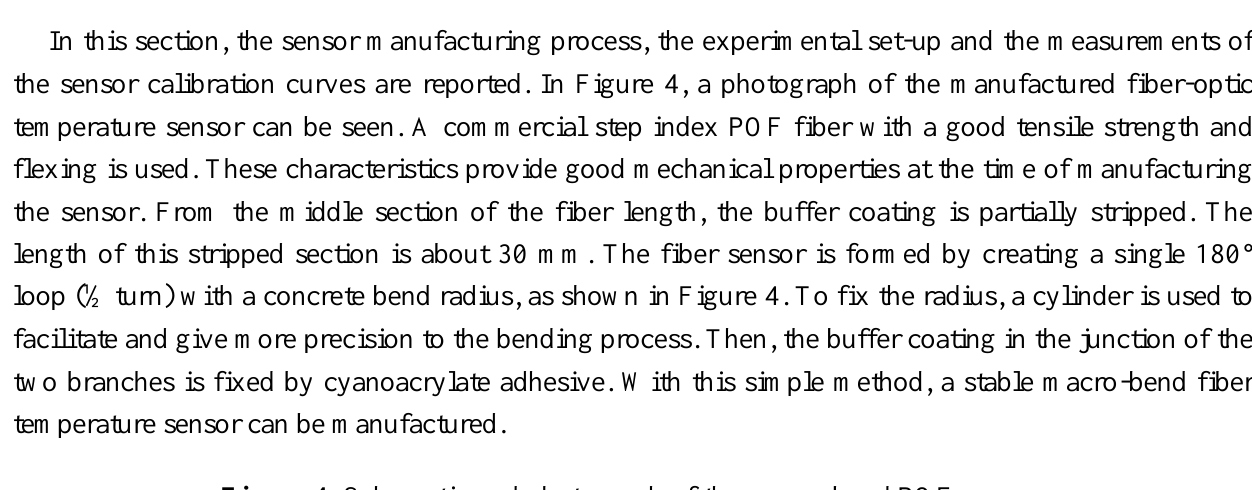
Figure 4. Schematic and photograph of the macro-bend POF